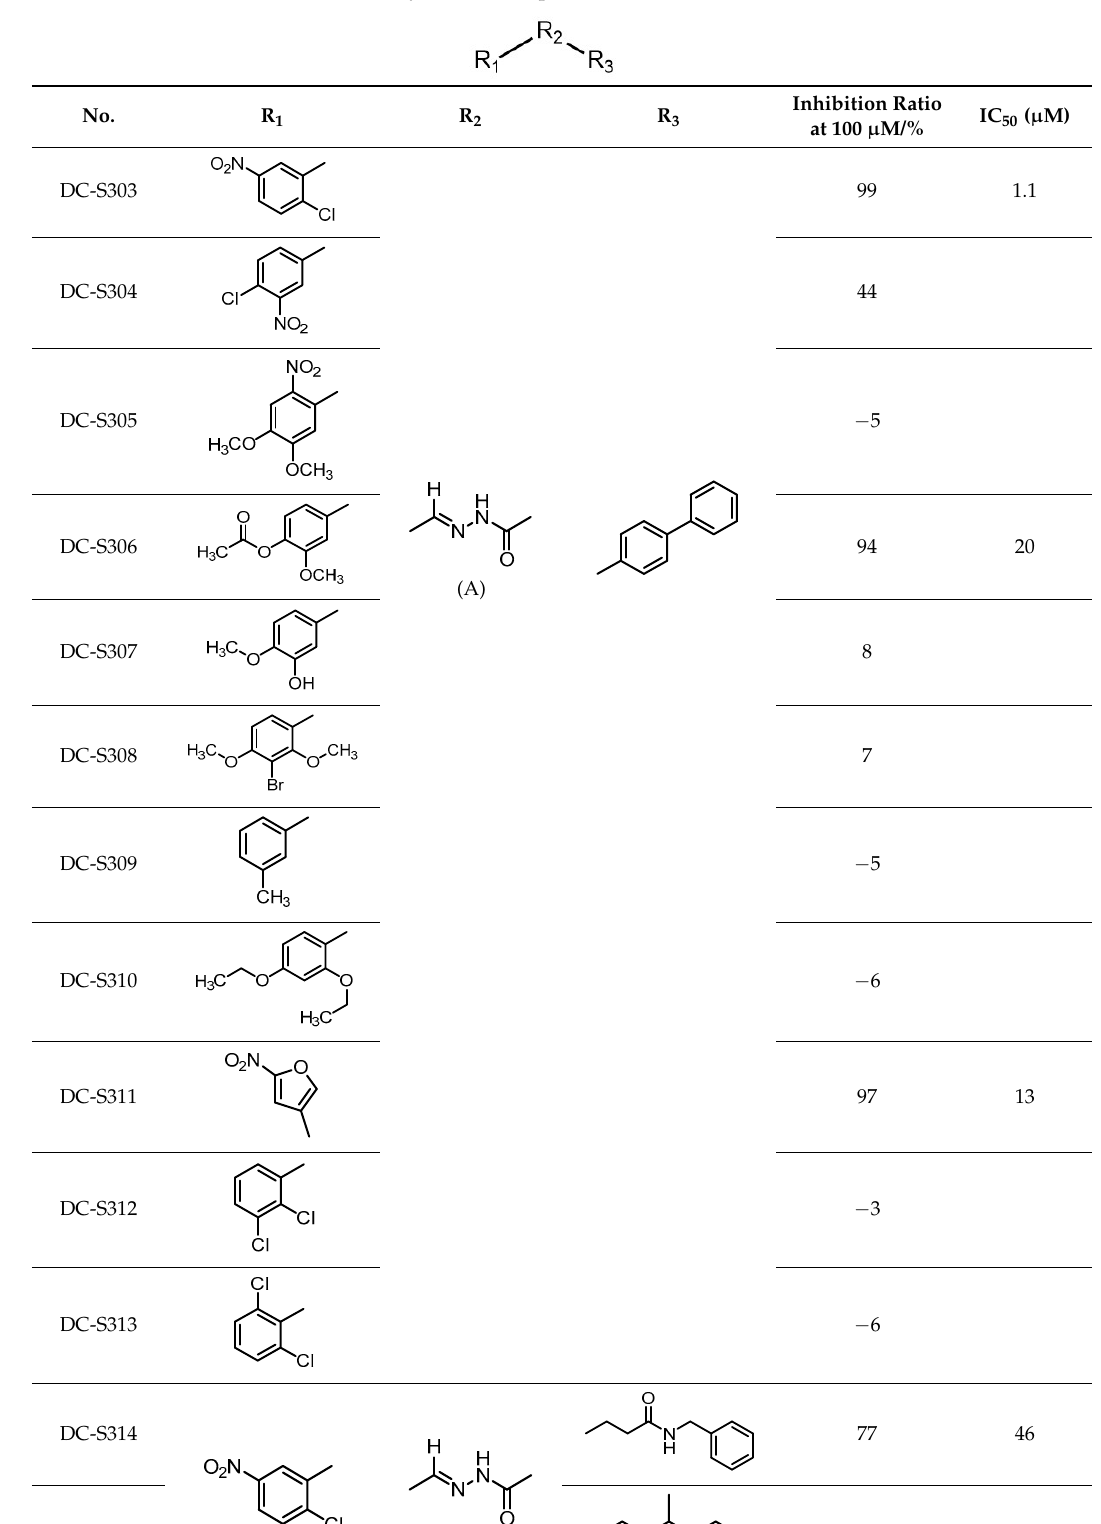
Table 2. Structure-Activity Relationship (SAR) of DC-S303 and its derivatives.